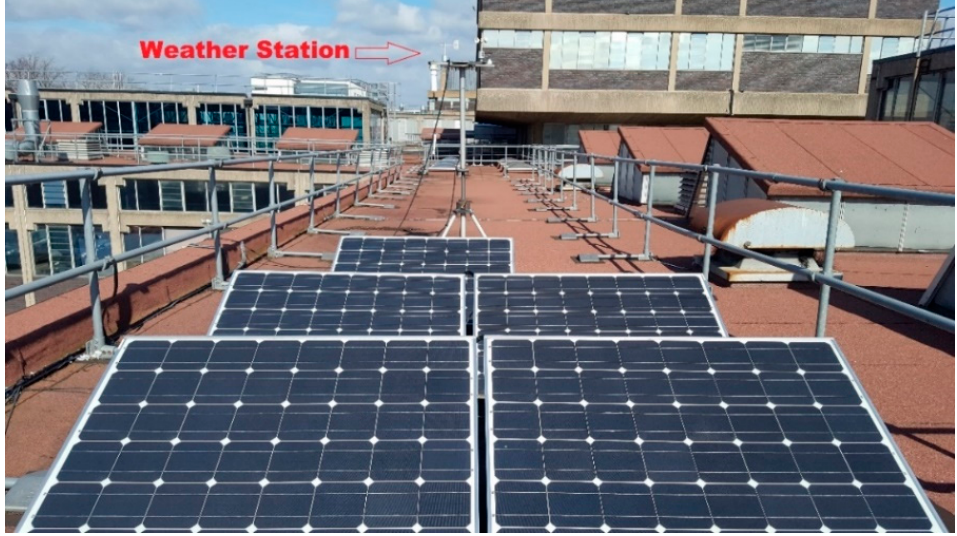
Figure 3. The studied PV array installed at Brunel University London, UK.